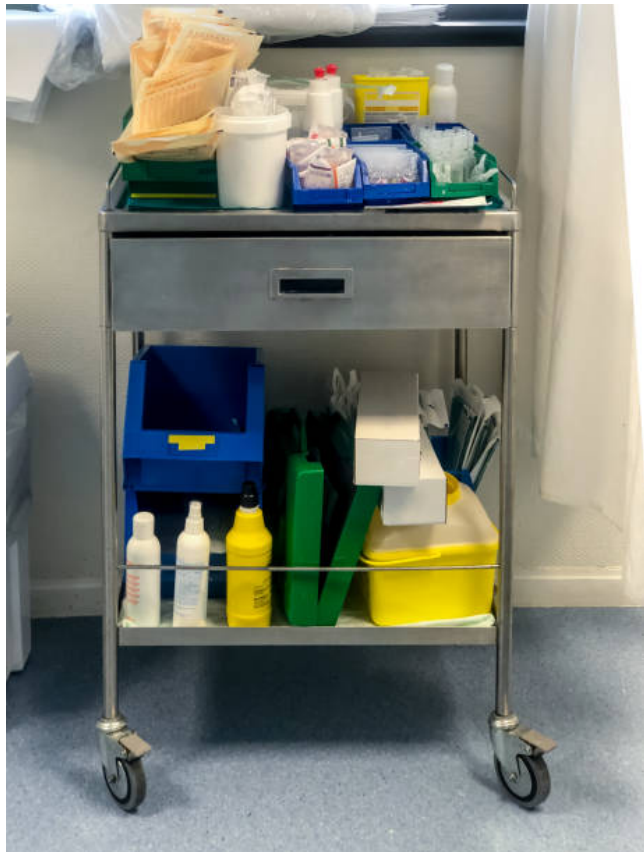
Figure 7. Typical medical supply cart used in